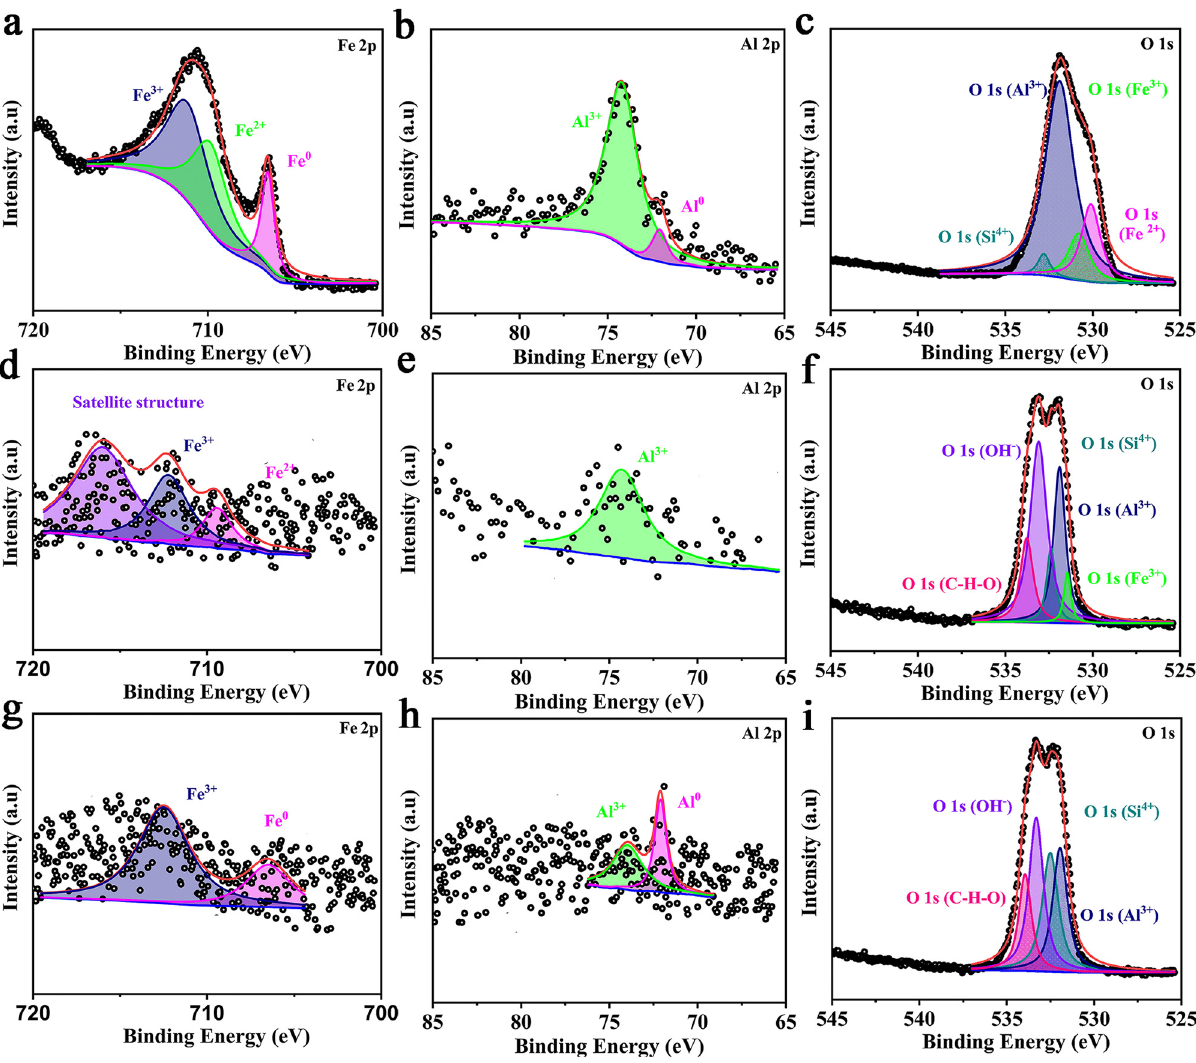
Figure 2: High - resolution XPS spectra of ( a ) Fe 2p, ( b ) Al 2p, and ( c ) O 1s recorded for FSA. High - resolution XPS spectra of ( d ) Fe 2p, ( e ) Al 2p, and ( f ) O 1s recorded for FSA10NA. High - resolution XPS spectra of ( g ) Fe 2p, ( h ) Al 2p, and ( i ) O 1s recorded for